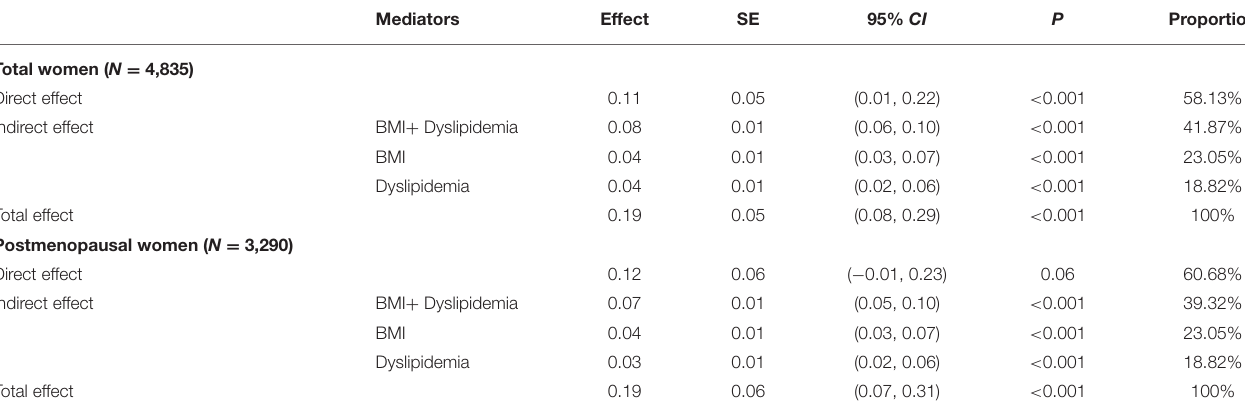
TABLE 4 | Multiple parallel mediation effect of baseline BMI and dyslipidemia on the relation of baseline SUA and risk of diabetes in